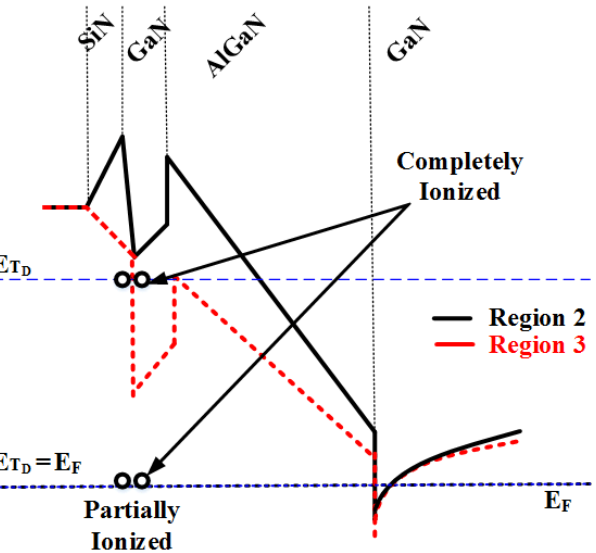
Figure 10. The conduction band variations illustrate the effect of surface donor traps on the 2DEG density in Regions 2 and 3. If E TD aligns with E F , the surface donor traps are partially ionized, whereas when the E TD locates effectively above the Fermi level, all the donor states are completely ionized.